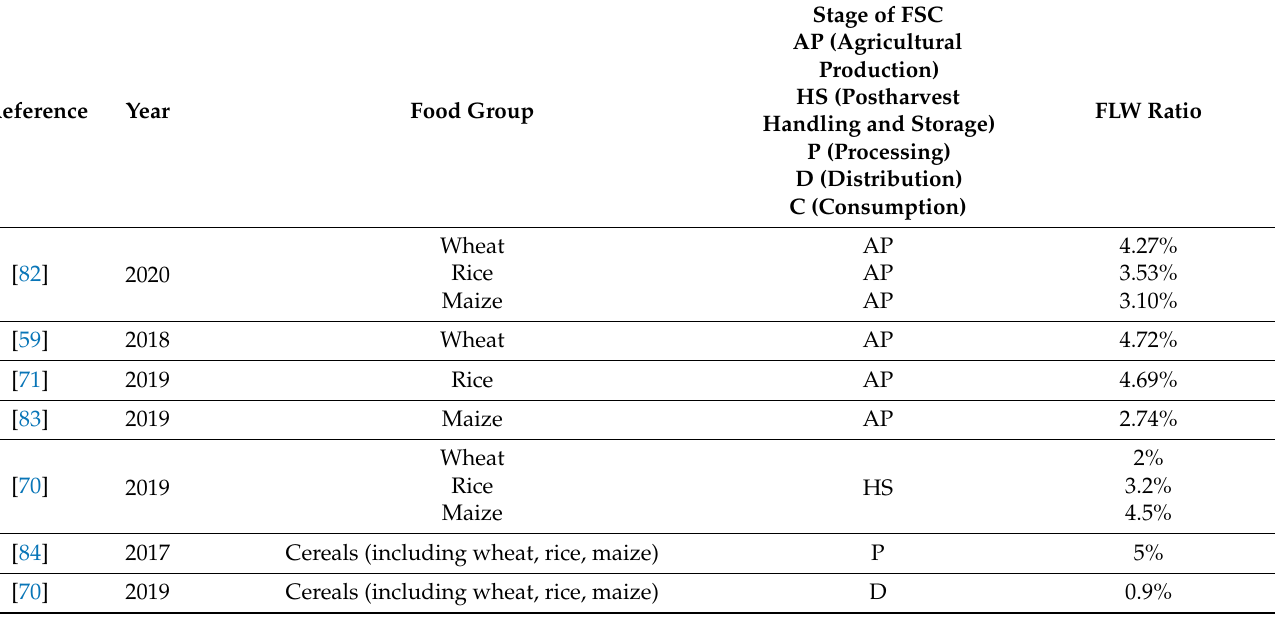
Table A1. Comparison of the FLW obtained in this study with studies in other